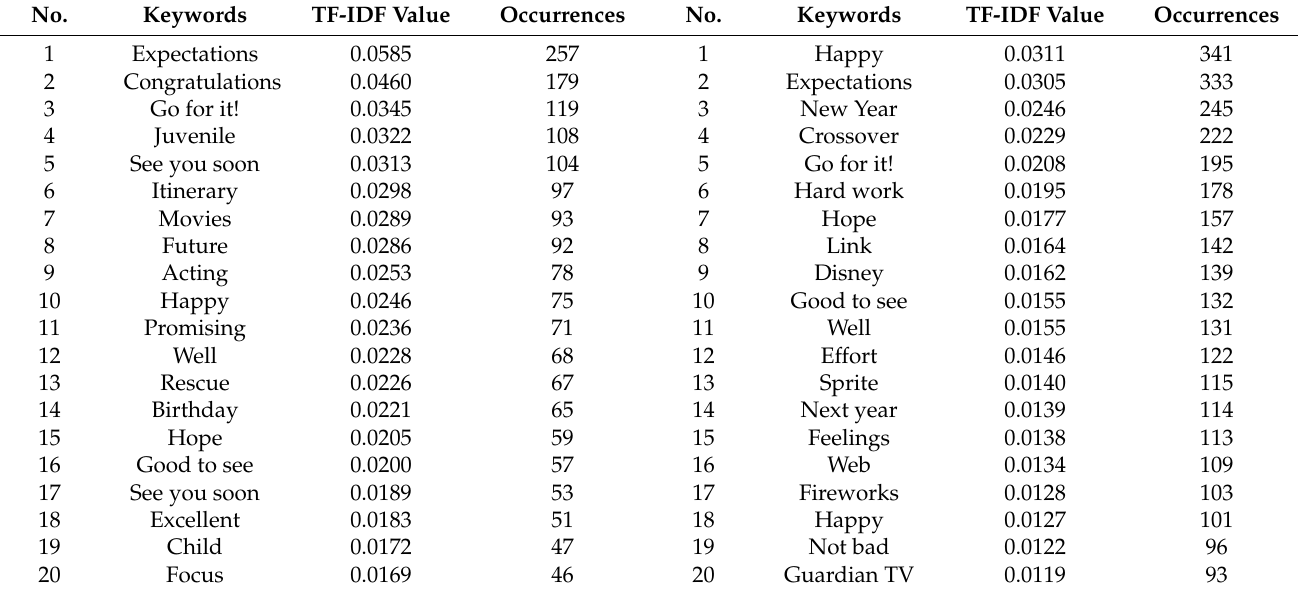
Table 3. Top 20 keywords in A3 and A4.